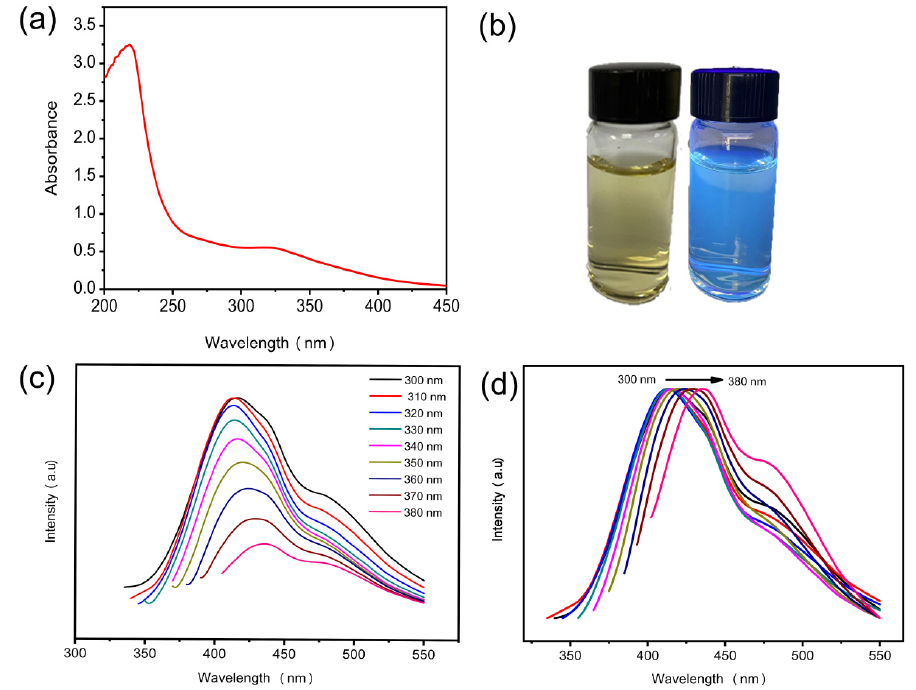
Figure 3. ( a ) UV-Vis absorption spectrum of N-CQDs, ( b ) N-CQDs solution under visible light (left) and UV light with the wavelength of 365 nm (right), respectively, ( c ) Fluorescence spectra of N-CQDs excited at changed wavelengths, and ( d ) Normalized fluorescence spectra of N-CQDs excited at wavelength of 300–380 nm.